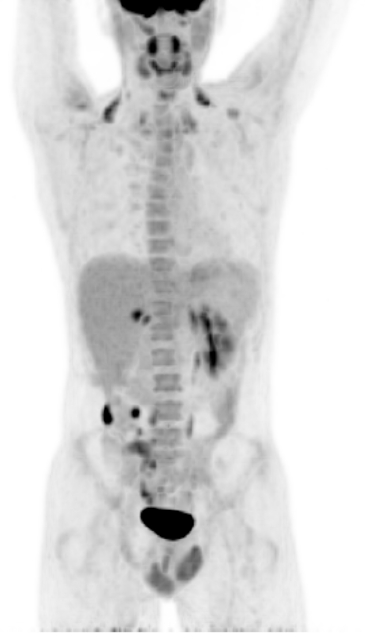
Figure 2. Biopsy showing papillary and tubular renal carcinoma ( a ): Histological section with hematoxylin-eosin stain showing renal cell carcinoma with eosinophilic nucleolus surrounded by perinuclear halo. ( b ): Histological section showing loss of expression of FH. Scale bar 100 µ m.